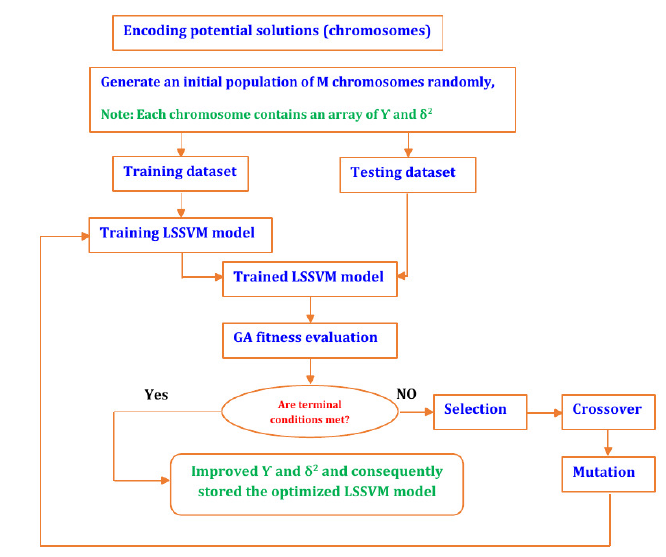
Figure 1. The overall scheme of the GA-least squares support vector machine method